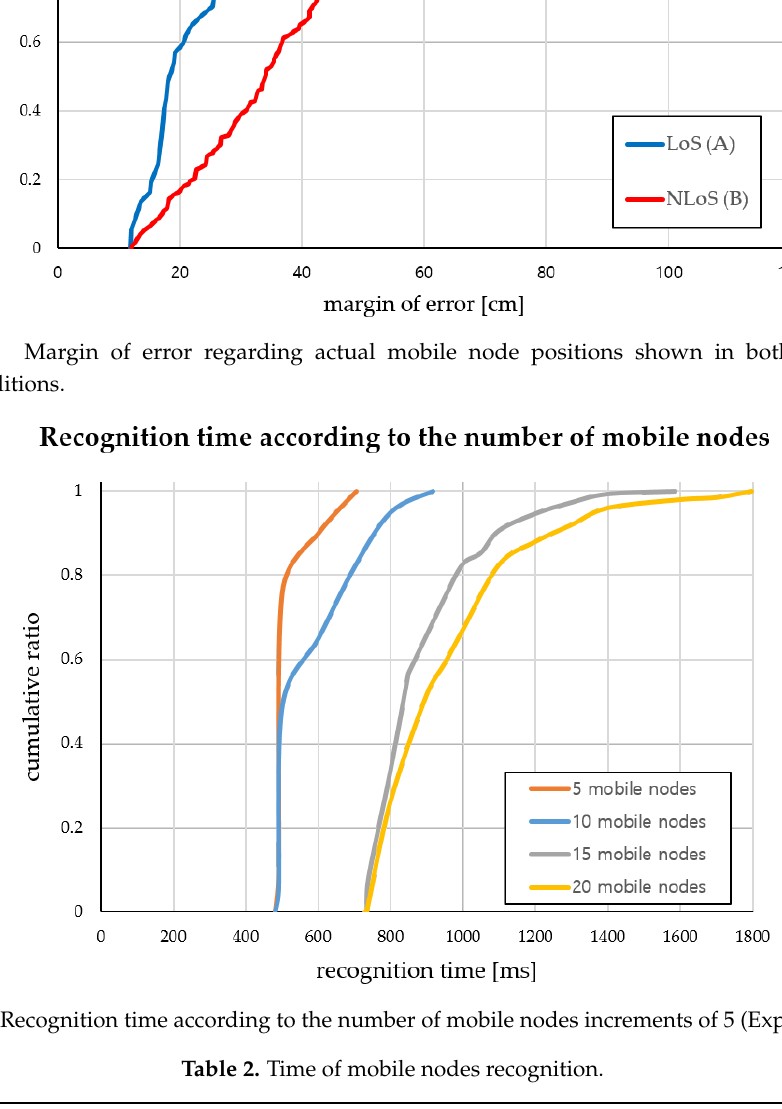
Table 2. Time of mobile nodes recognition.